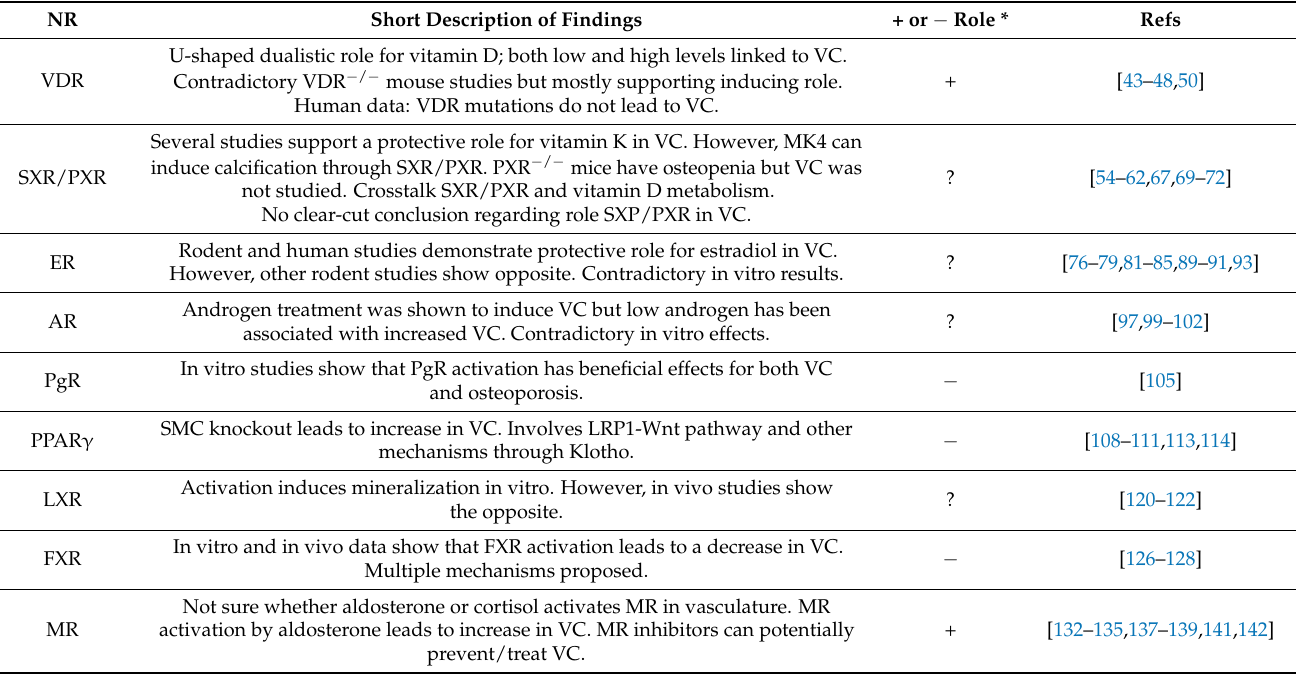
Table 1. List of NRs and their roles in